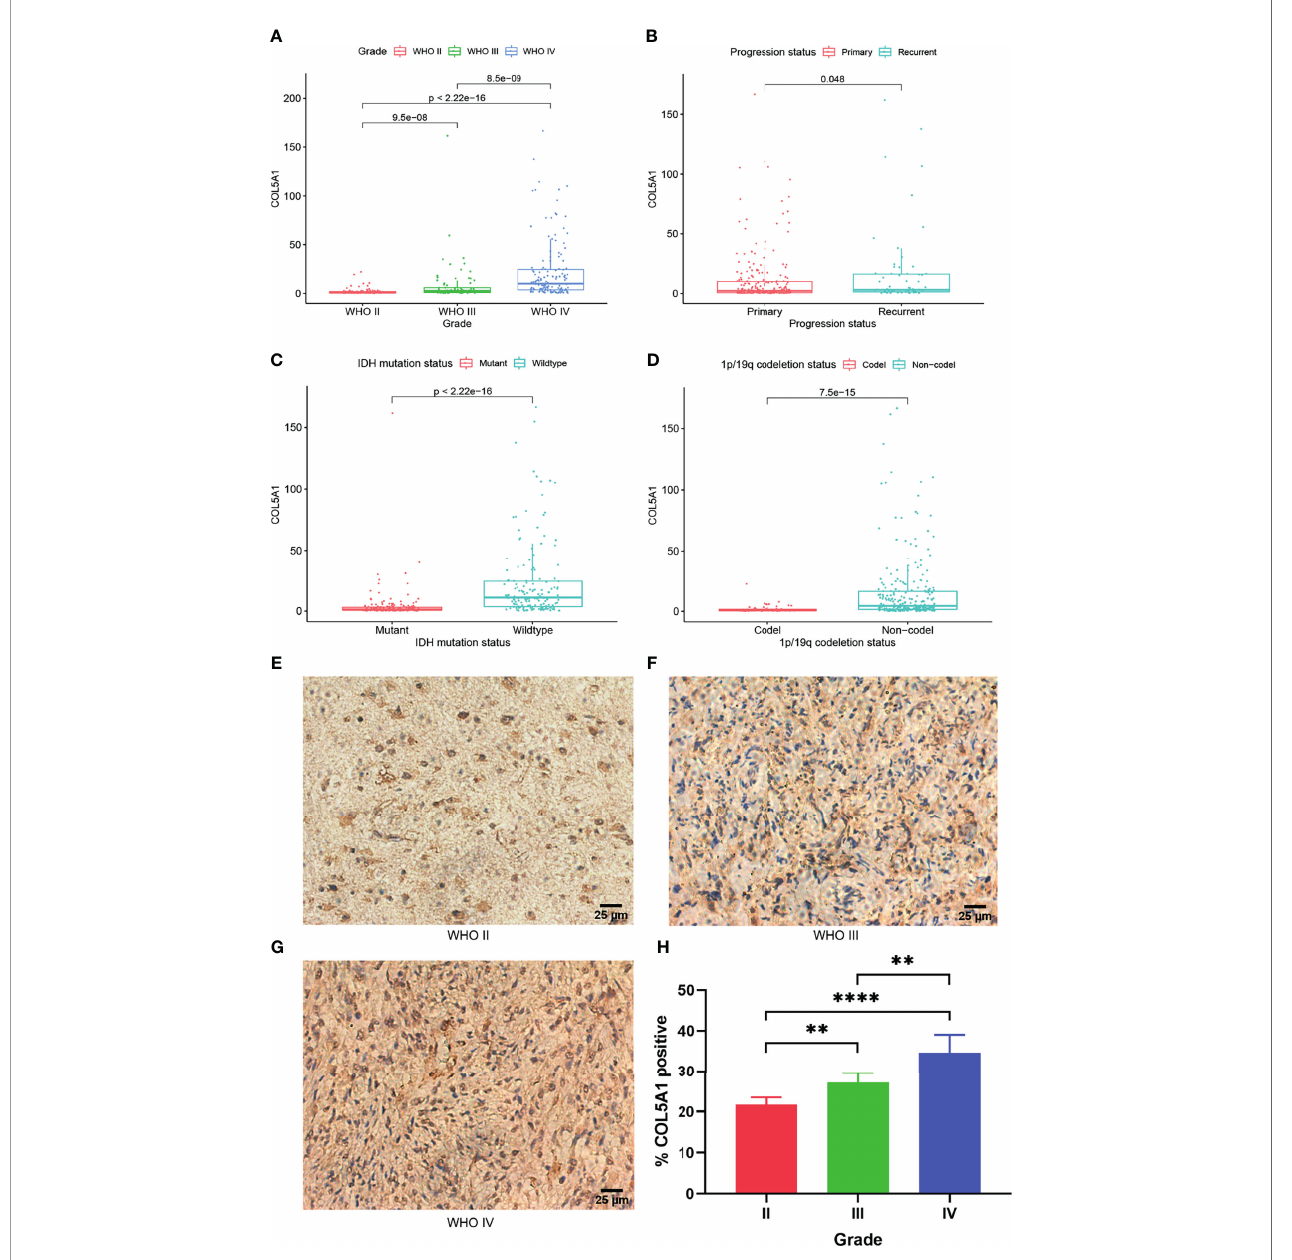
FIGURE 1 | COL5A1 is correlated with multiple malignant features of gliomas. (A) Expression levels of COL5A1 in gliomas of different grades. (B) Expression levels of COL5A1 in primary and recurrent gliomas. (C) Expression levels of COL5A1 in gliomas with IDH mutant and wild types. (D) Expression levels of COL5A1 in gliomas with 1p/19q co-deletion and non-co-deletion. (E – H) Representative images of IHC staining of COL5A1 in different grades glioma tissues and the corresponding % positive area (**p < 0.01; ****p <